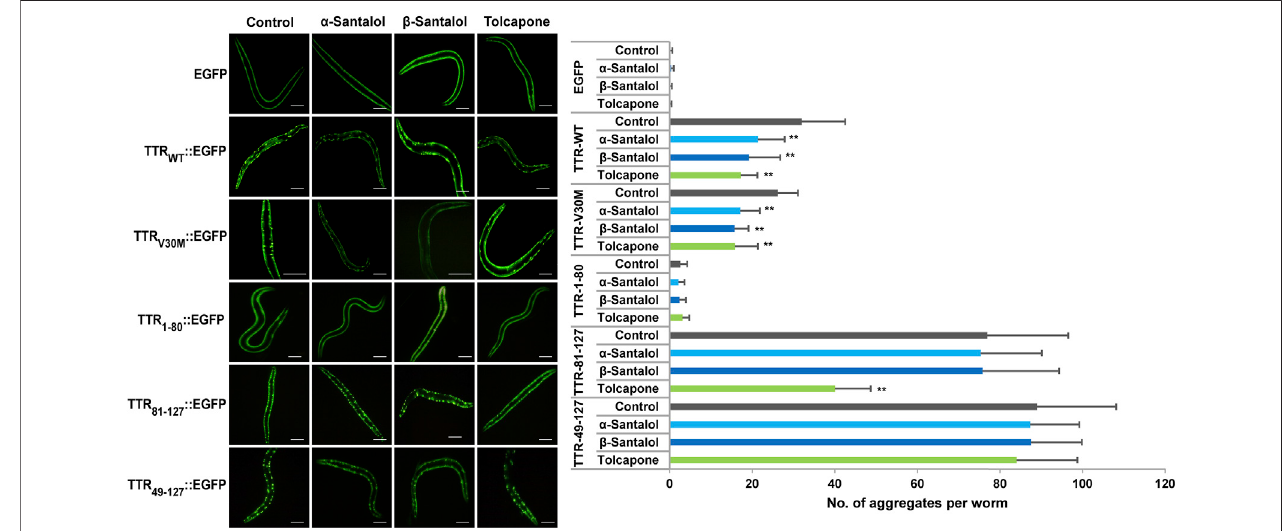
FIGURE3| InhibitoryeffectofsantalolisomersontheformationofTTRaggregatesinday6adulthoodworms. C.elegans strainsexpressingEGFP,TTR WT ::EGFP, TTR V30M ::EGFP,TTR 1 – 80 ::EGFP,TTR 81 – 127 ::EGFP,andTTR 49 – 127 :EGFPwereused.Thescalebarrepresents100 μ m.Dataarepresentedasmean±SD;** p < 0.01vs. control. See Supplementary Table S2 for more detailed statistics.